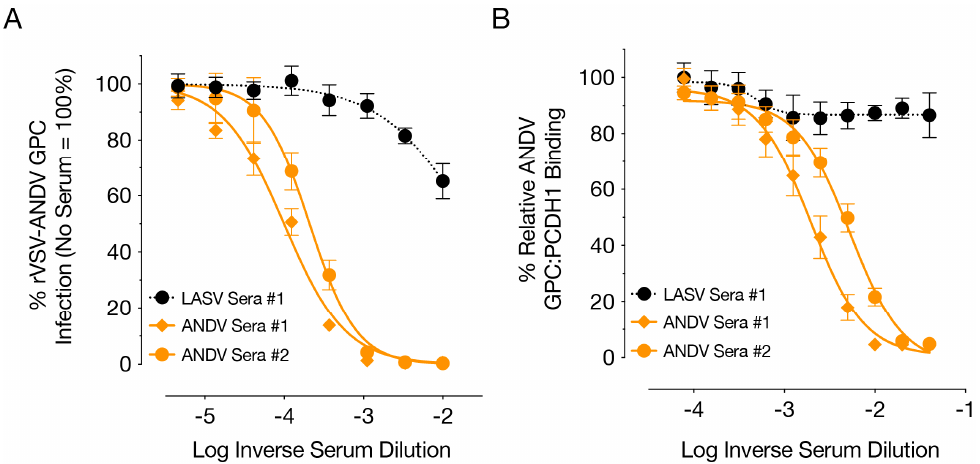
Figure 3. Blocking of ANDV GPC:PCDH1 interaction by hamster sera. ( A ) Neutralization activity of sera from vaccinated hamsters was assessed using primary human endothelial cells infected with rVSV Δ G/ANDVGPC. Average ± SD ( n = 6) from 3 independent experiments. ( B ) Ability of vaccinated hamster sera to block binding of ANDV GPC to soluble PCDH1 was assessed by competition ELISA. Mean ± SD ( n = 9) from 3 independent experiments.